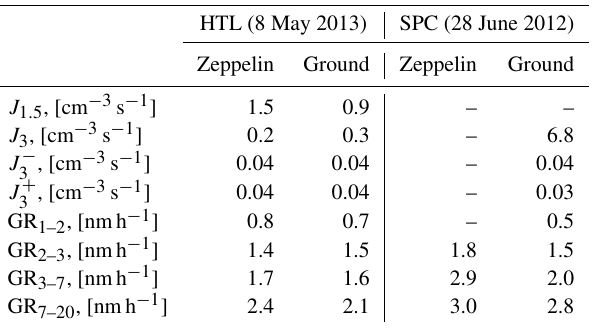
Table 1. Calculated particle formation and growth rates. + and − superscripts refer to positive and negative ions, respectively. The Zeppelin missed the beginning of the NPF event in SPC and because of that some values are